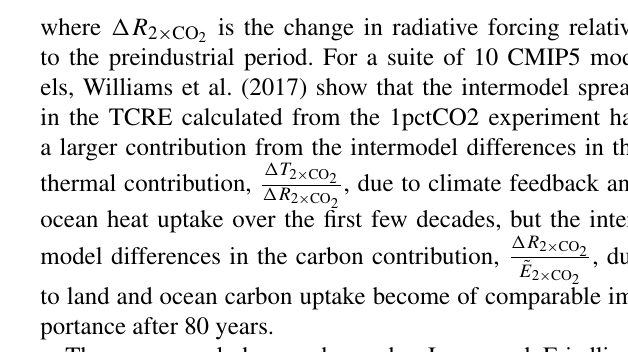
), diagnosed 2 ), and transient climate 2